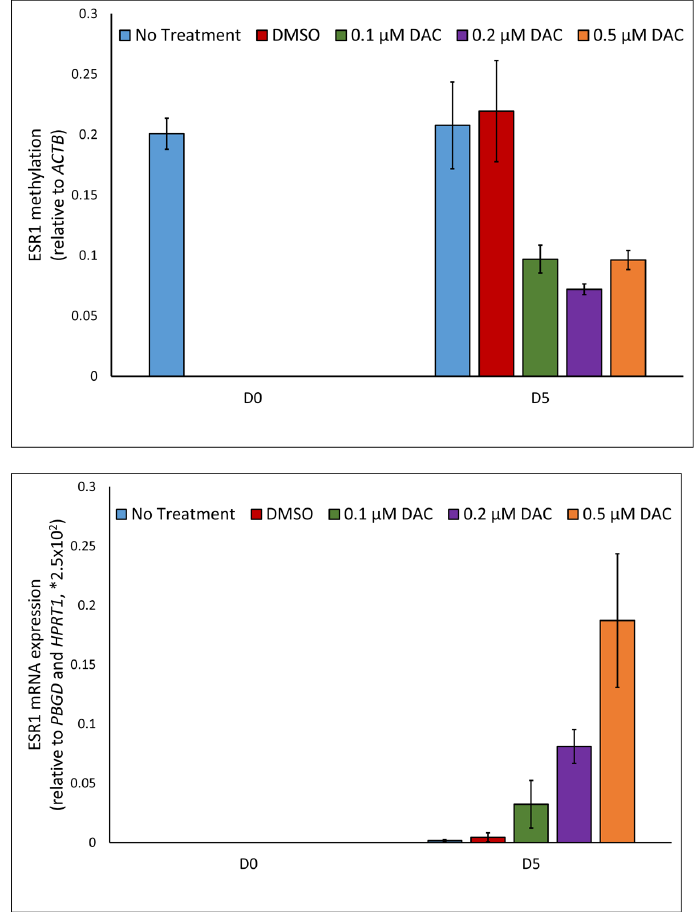
Figure 1. Restoration of ESR1 /ER after DAC treatment. ( Top ): Methylation decrease in ESR1 promotor region A is observed in MDA-MB-436 after DAC treatment by qMSP using the 2 − ∆ Ct method, compared to the ACTB housekeeping gene. ( Bottom ): Increased ER expression, measured by targeting ESR1 exon 4 mRNA after cDNA synthesis, is observed in MDA-MB-436 after DAC treatment by qPCR using the 2 − ∆ Ct method compared to the average of the PBGD and HPRT1 housekeeping genes. Error bars represent the standard deviation. * ESR1 expression levels were multiplied 250 × for scale unification.